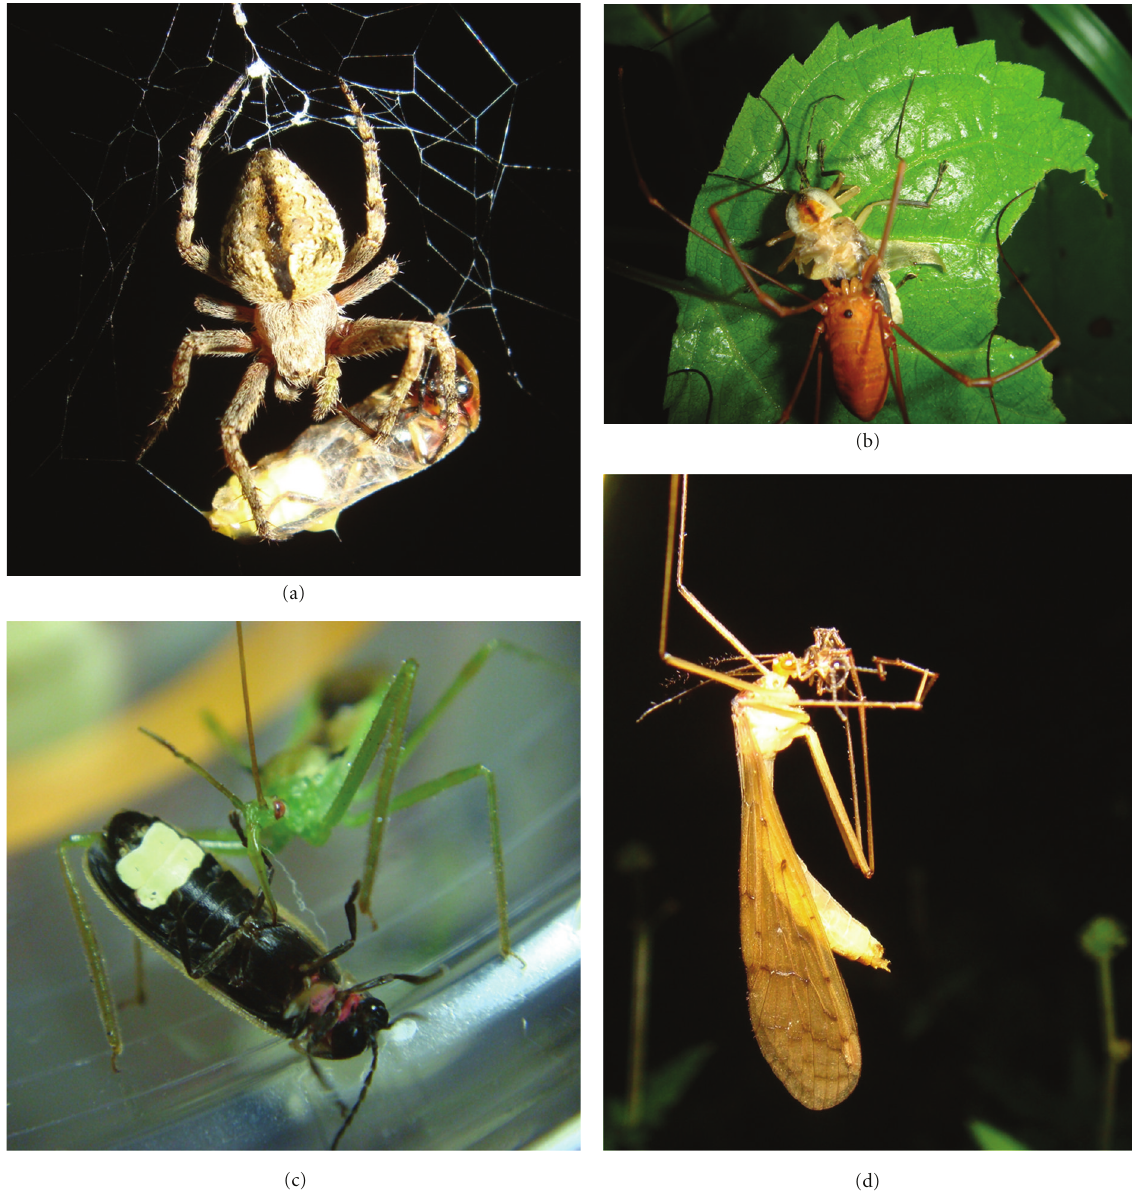
Figure 1: Some invertebrate predators of fireflies in the Great Smoky Mountains (photos by R. De Cock). (a) Orb-weaving spider (Araneidae) Cyclosa conica attacking a Photinus male that has been caught and wrapped. (b) Harvestman Leiobunum spp. (Opiliones: Phalangiidae) attacking a newly eclosed Photuris firefly. (c) Zelus luridus assassin bug (Hemiptera: Reduviidae) feeding on a male Photinus carolinus . (d) Bittacus spp. hangingfly (Mecoptera: Bittacidae) consuming a male Phausis reticulata